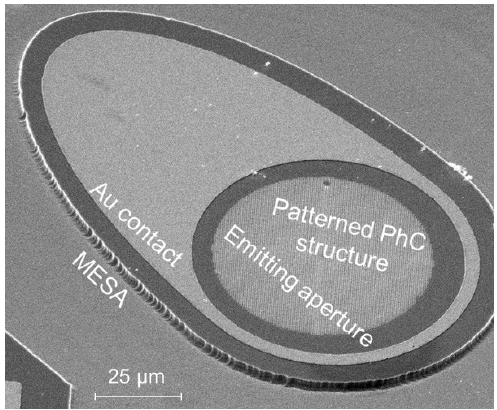
Figure 1. SEM image of AlGaAs/GaAs MQW LED patterned surface with photonic structure in the emitting part of the LED surface.